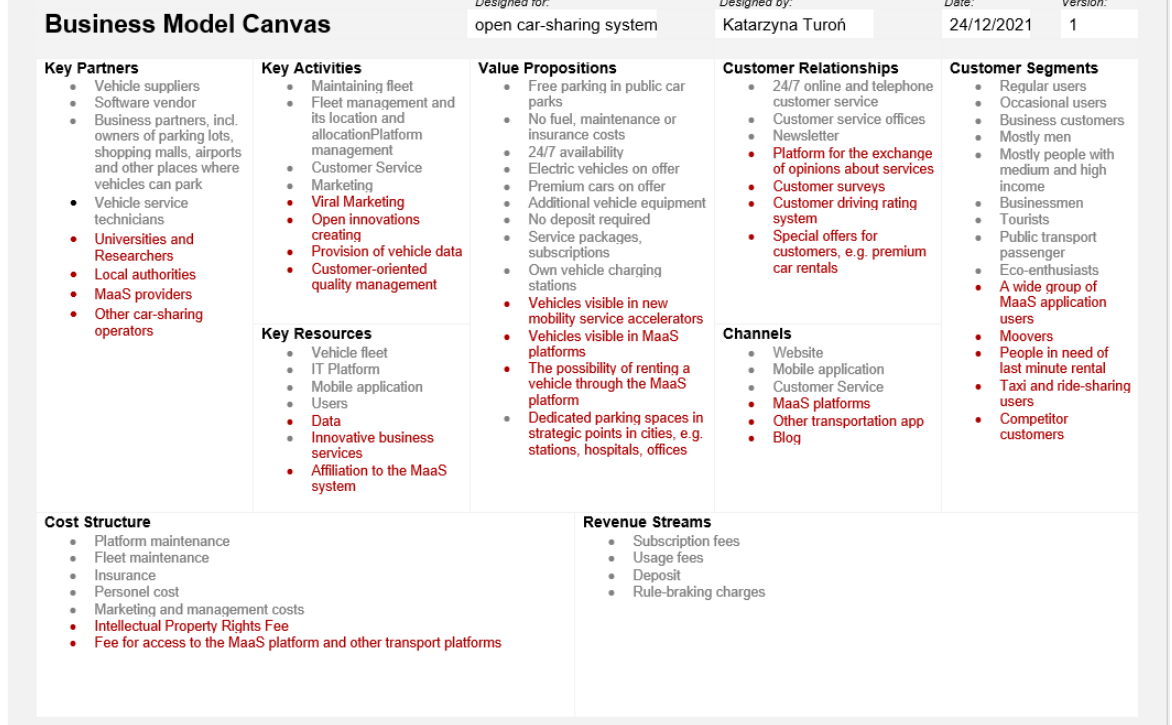
Figure 11. Open car-sharing business model based on the CANVAS concept.